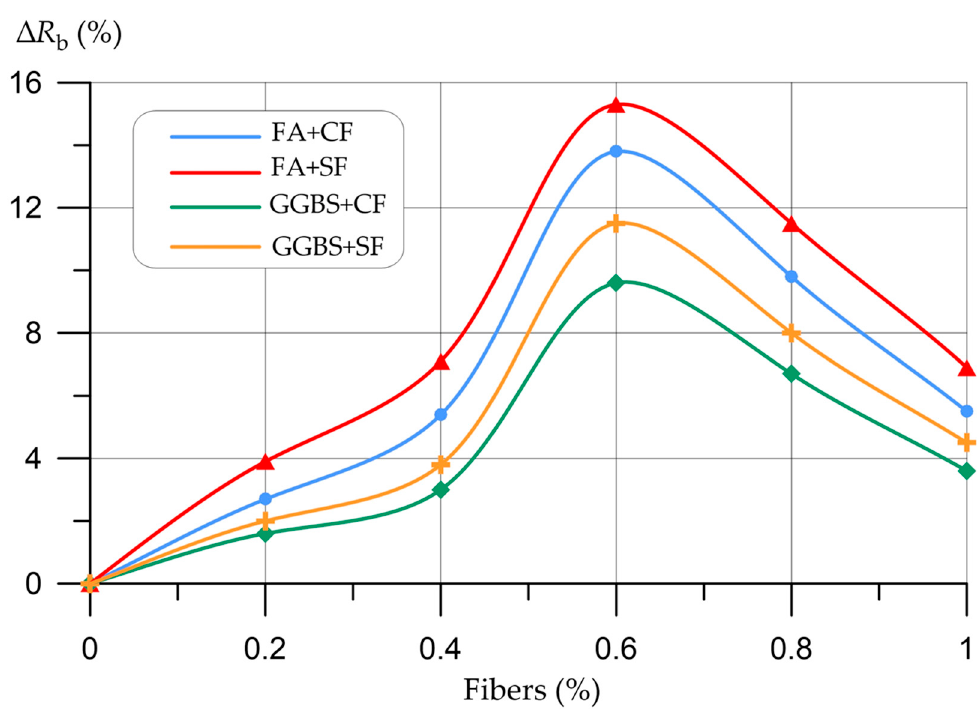
Figure 12. Changes in CS of modified non-autoclaved aerated concrete with different fiber content (FA + CF—aerated concrete modified with FA and reinforced with CF; GGBS + CF—aerated concrete modified with GGBS and reinforced with CF; FA + SF—aerated concrete modified with FA and reinforced with SF; and GGBS +SF—aerated concrete modified with GGBS and reinforced with SF).